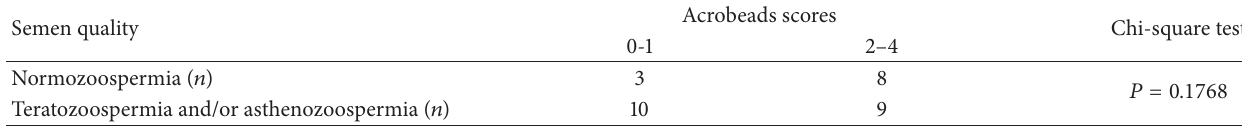
Table 1: Acrobeads scores and the results of the semen analysis.